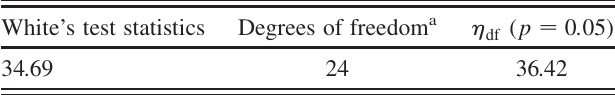
TABLE X. White’s test of no heteroskedasticity against heter- oskedasticity of some unknown general